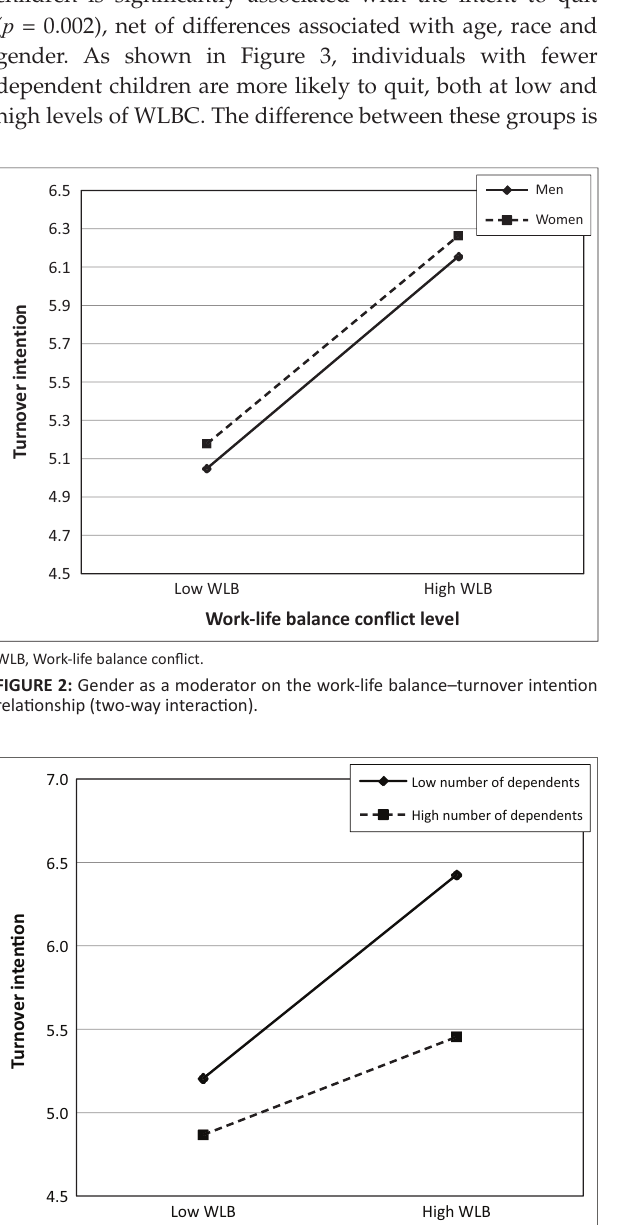
WLB, Work-life balance conflict. FIGURE 3: Number of dependents as moderator on the work-life balance– turnover intention relationship (two-way interaction).